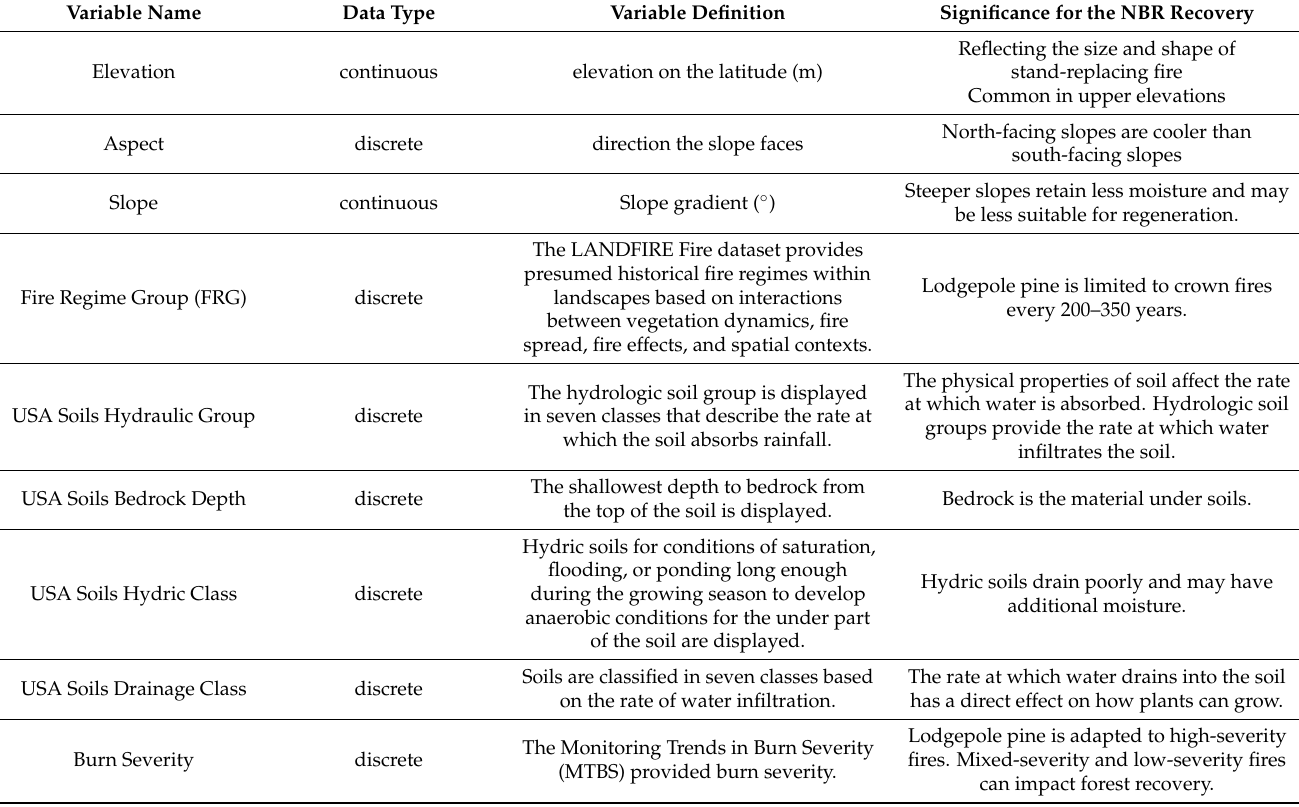
Table 3. Explanatory topographic variables impact on the NBR change